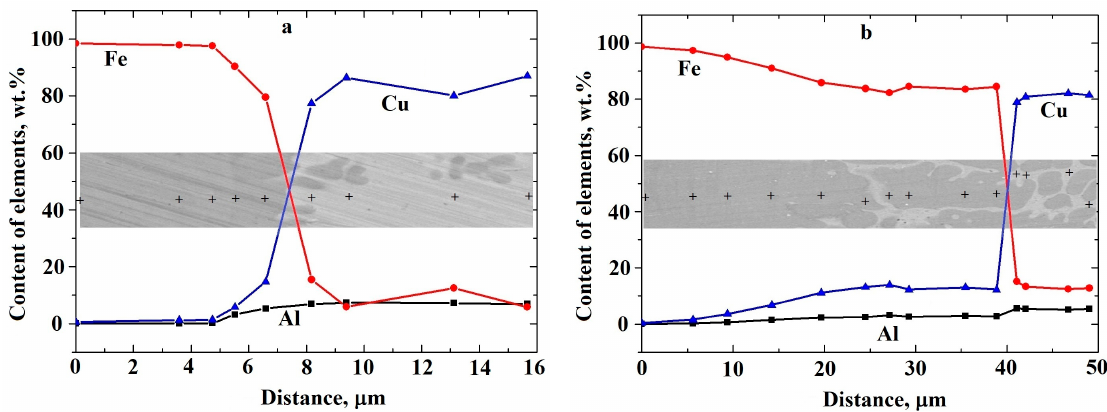
Figure 7. The results of the X-ray microanalysis for the contact zone of sample: ( a ) No. 1; ( b ) No. 5.